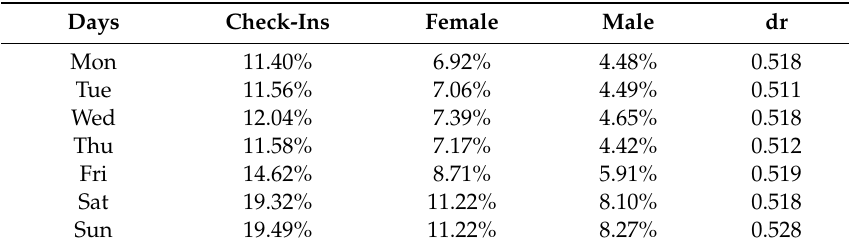
Table 6. Gender di ff erence during the week. dr: relative di ff erence.